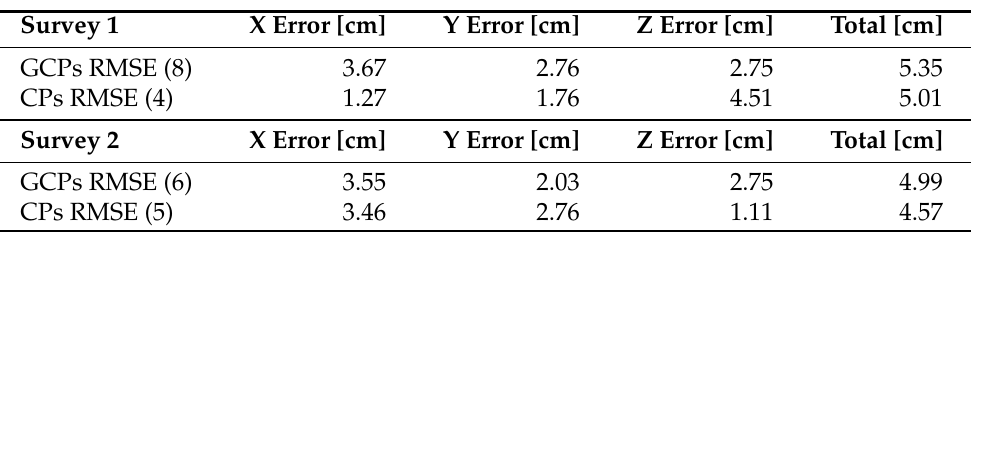
Figure 5. Workflow of the adopted experimentation to validate the proposed methodology. Table 6. GCPs and CPs RMSE of Surveys 1 and